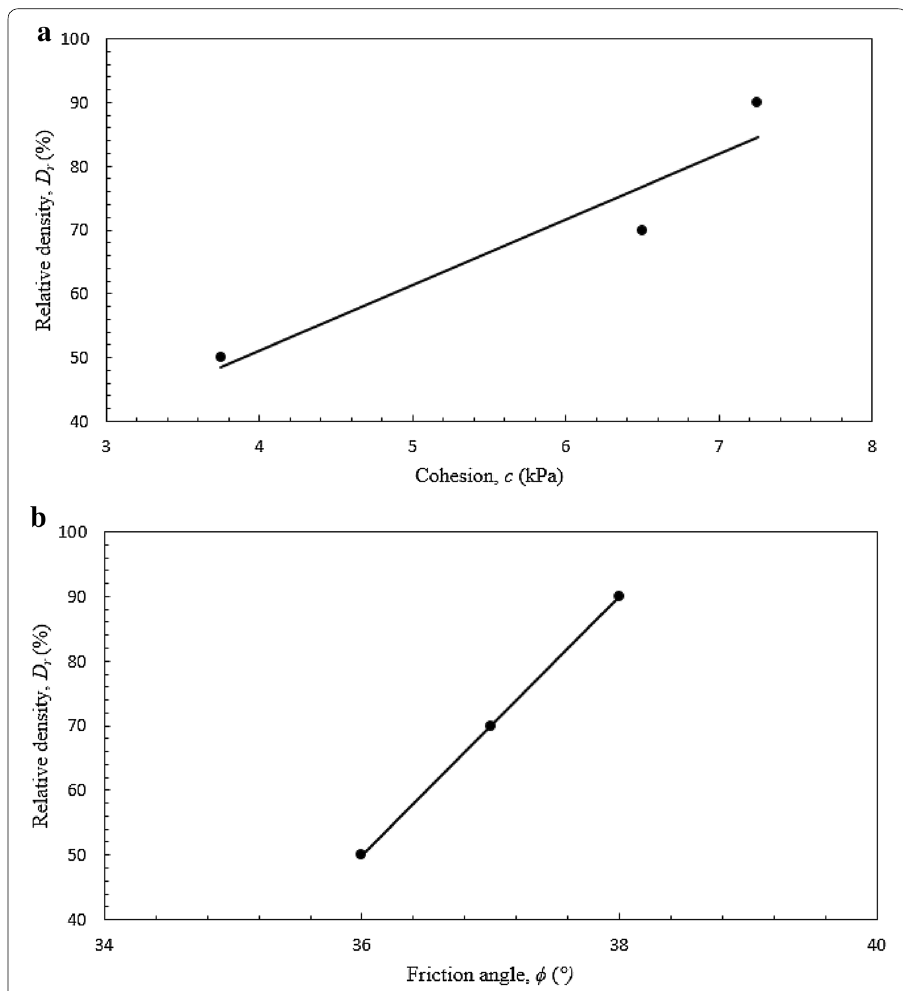
Fig. 4 Correlation of the slope soil relative density, D r with: a cohesion, c , b friction angle,